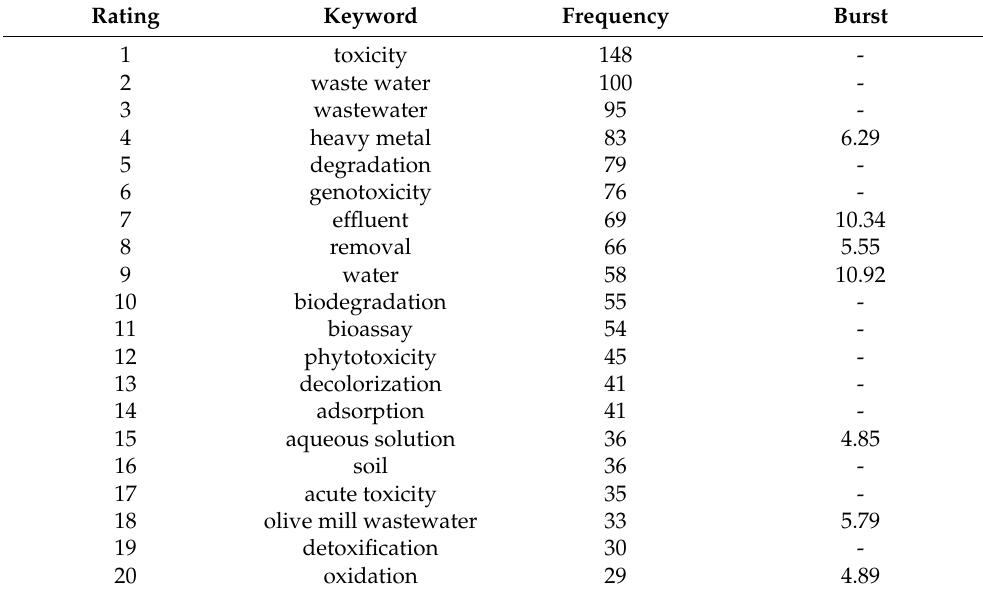
Table 2. The keywords’ characteristics appeared in the scientific documents published in the indus- trial effluent and sludge toxicity analysis regarding their scientometric specifications (frequency and burst). These results have been gained from the analysis performed via the utilization of CiteSpace software. The symbol “-” utilized represents that the specific keyword does not have any value corresponding to a burst in any duration of